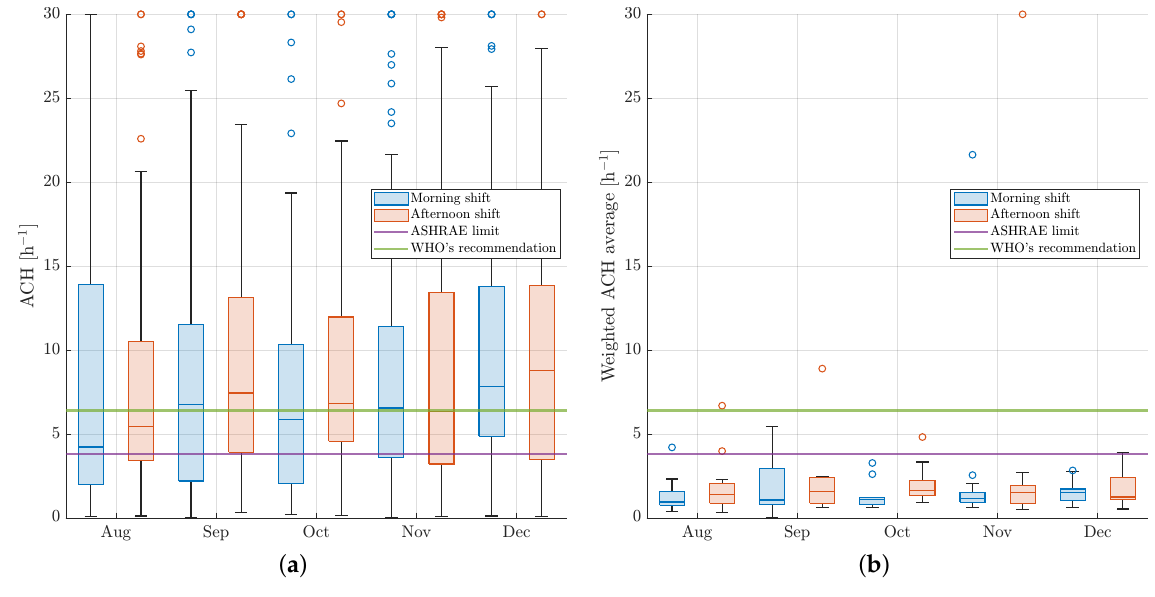
Figure 6. Monthly ACH results. ( a ) shows mean ACH results computed from all the box model adjustments. ( b ) shows results computed from daily time-weighted ACH averages. Results for both occupation shifts are included, as well as the minimum ventilation rate indicated by the ASHRAE 62.1 standard and WHO’s pandemic recommendation.